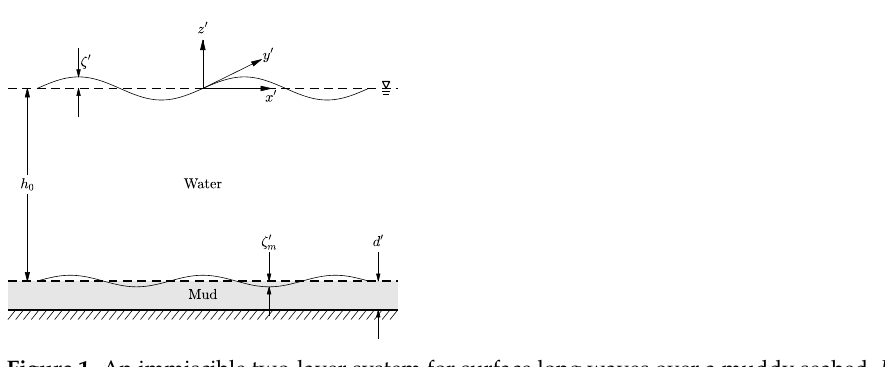
Figure 1. An immiscible two-layer system for surface long waves over a muddy seabed. h 0 = water depth, d (cid:48) = mud thickness, ζ (cid:48) = free-surface displacement, ζ (cid:48) m = water–mud interfacial displacement, ( x (cid:48) , y (cid:48) ) = horizontal coordinates, z (cid:48) = vertical axis. The mud layer is on top of a solid